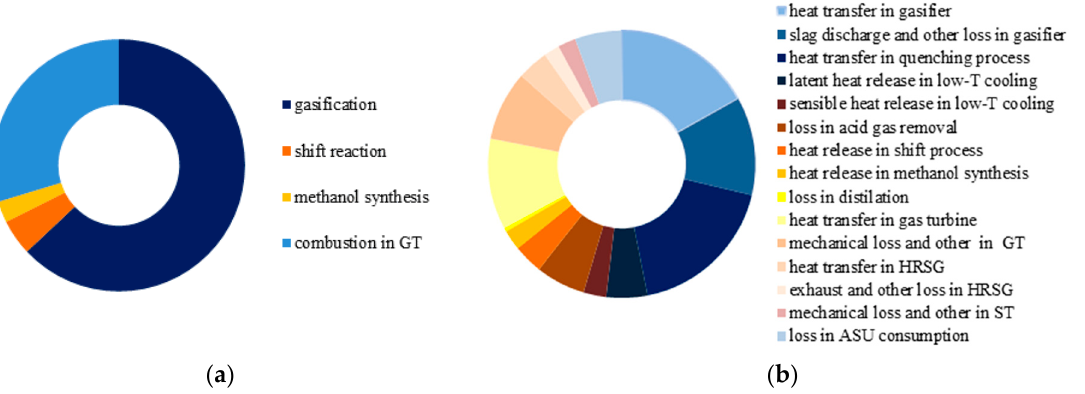
Figure 4. Structure of exergy loss in the base case. ( a ) chemical processes; ( b ) physical processes.